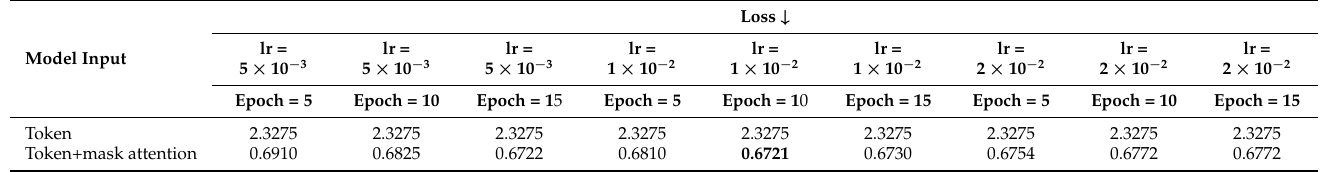
Table 3. With all Transformer block parameters of GPT-2 frozen, only the linear layer is trained to validate the results of the set on the CoLA